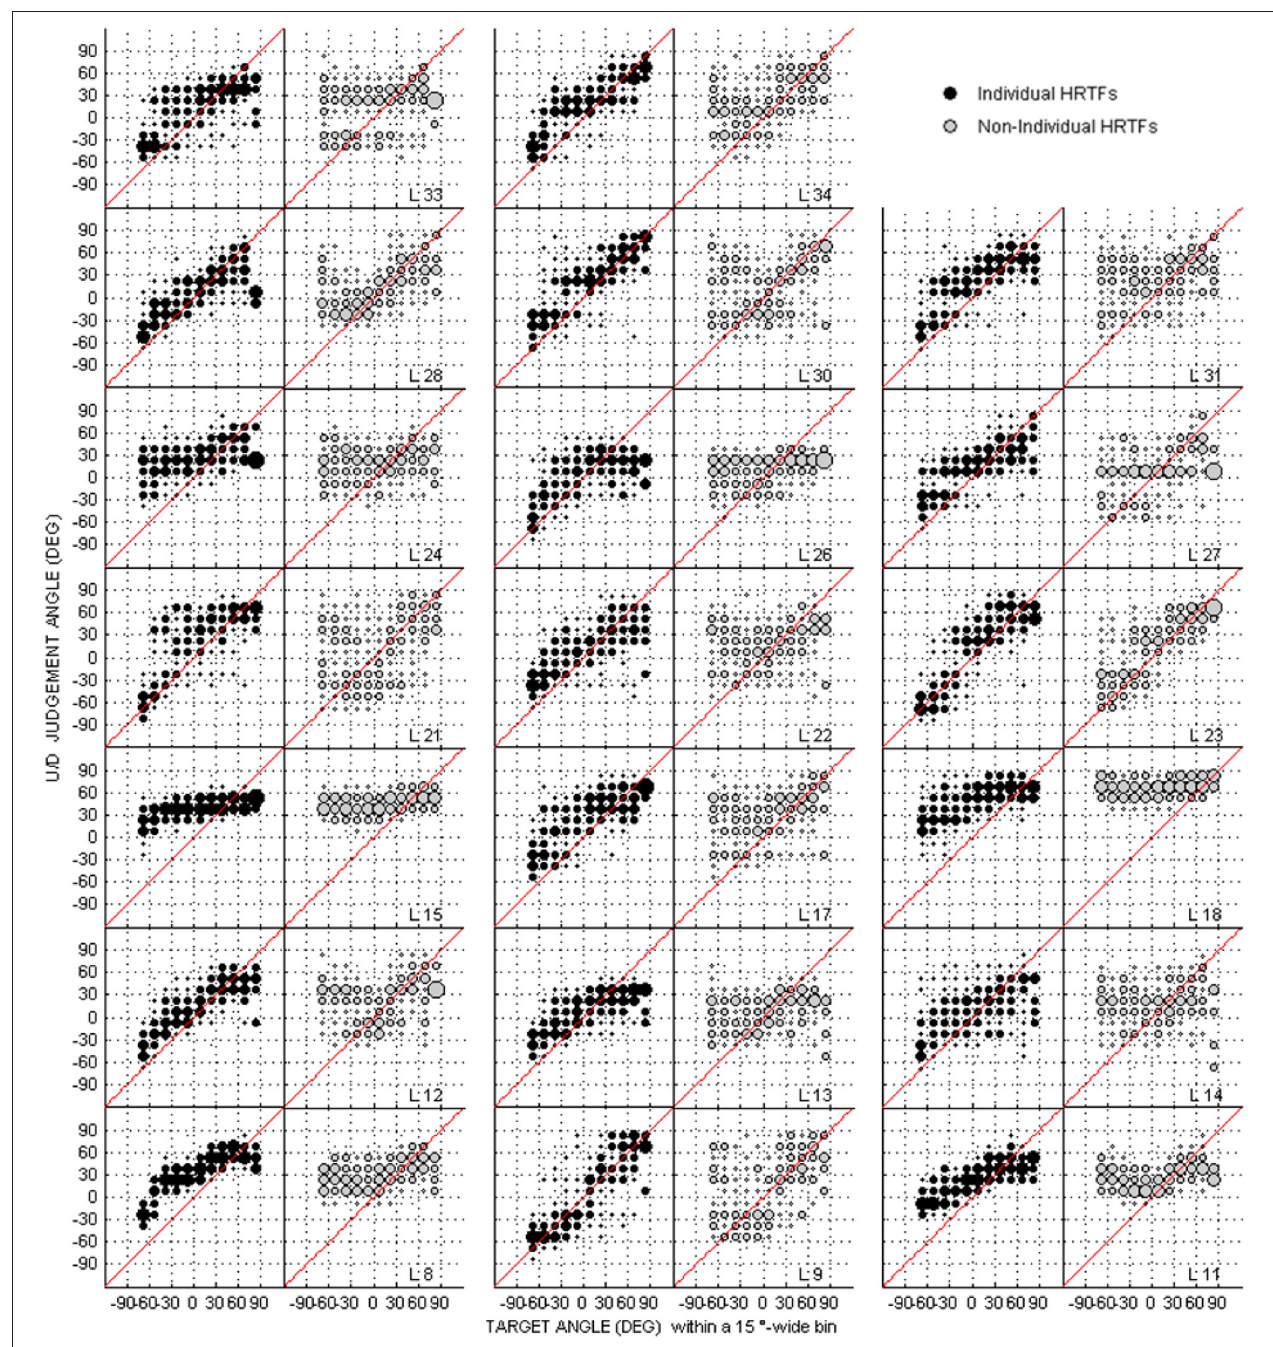
FIGURE 2 | Individual judgment position against target position with individual and non-individual HRTFs (black and gray dots, respectively) at the pre-test in the up/down dimension. Each panel couple is for a different listener ( N = 20).